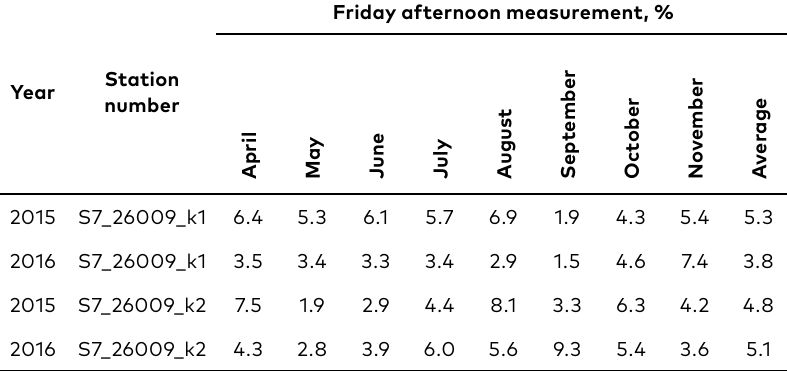
Table 5. Mean Absolute Percentage Error of the method for estimating the Design Hourly Volume according to correction